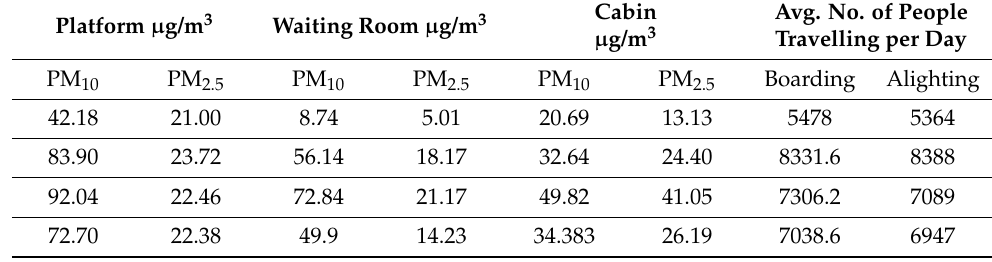
Table 1. Average concentrations of PM 10 and PM 2.5 and average number of patients traveled.